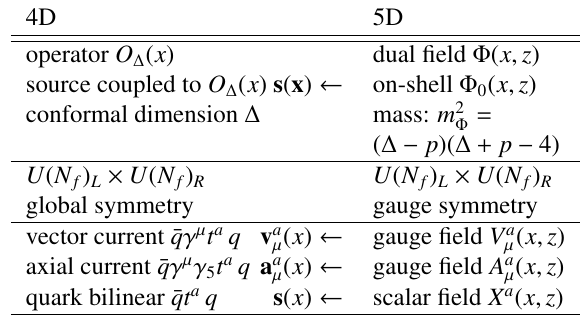
Table 1. The holographic